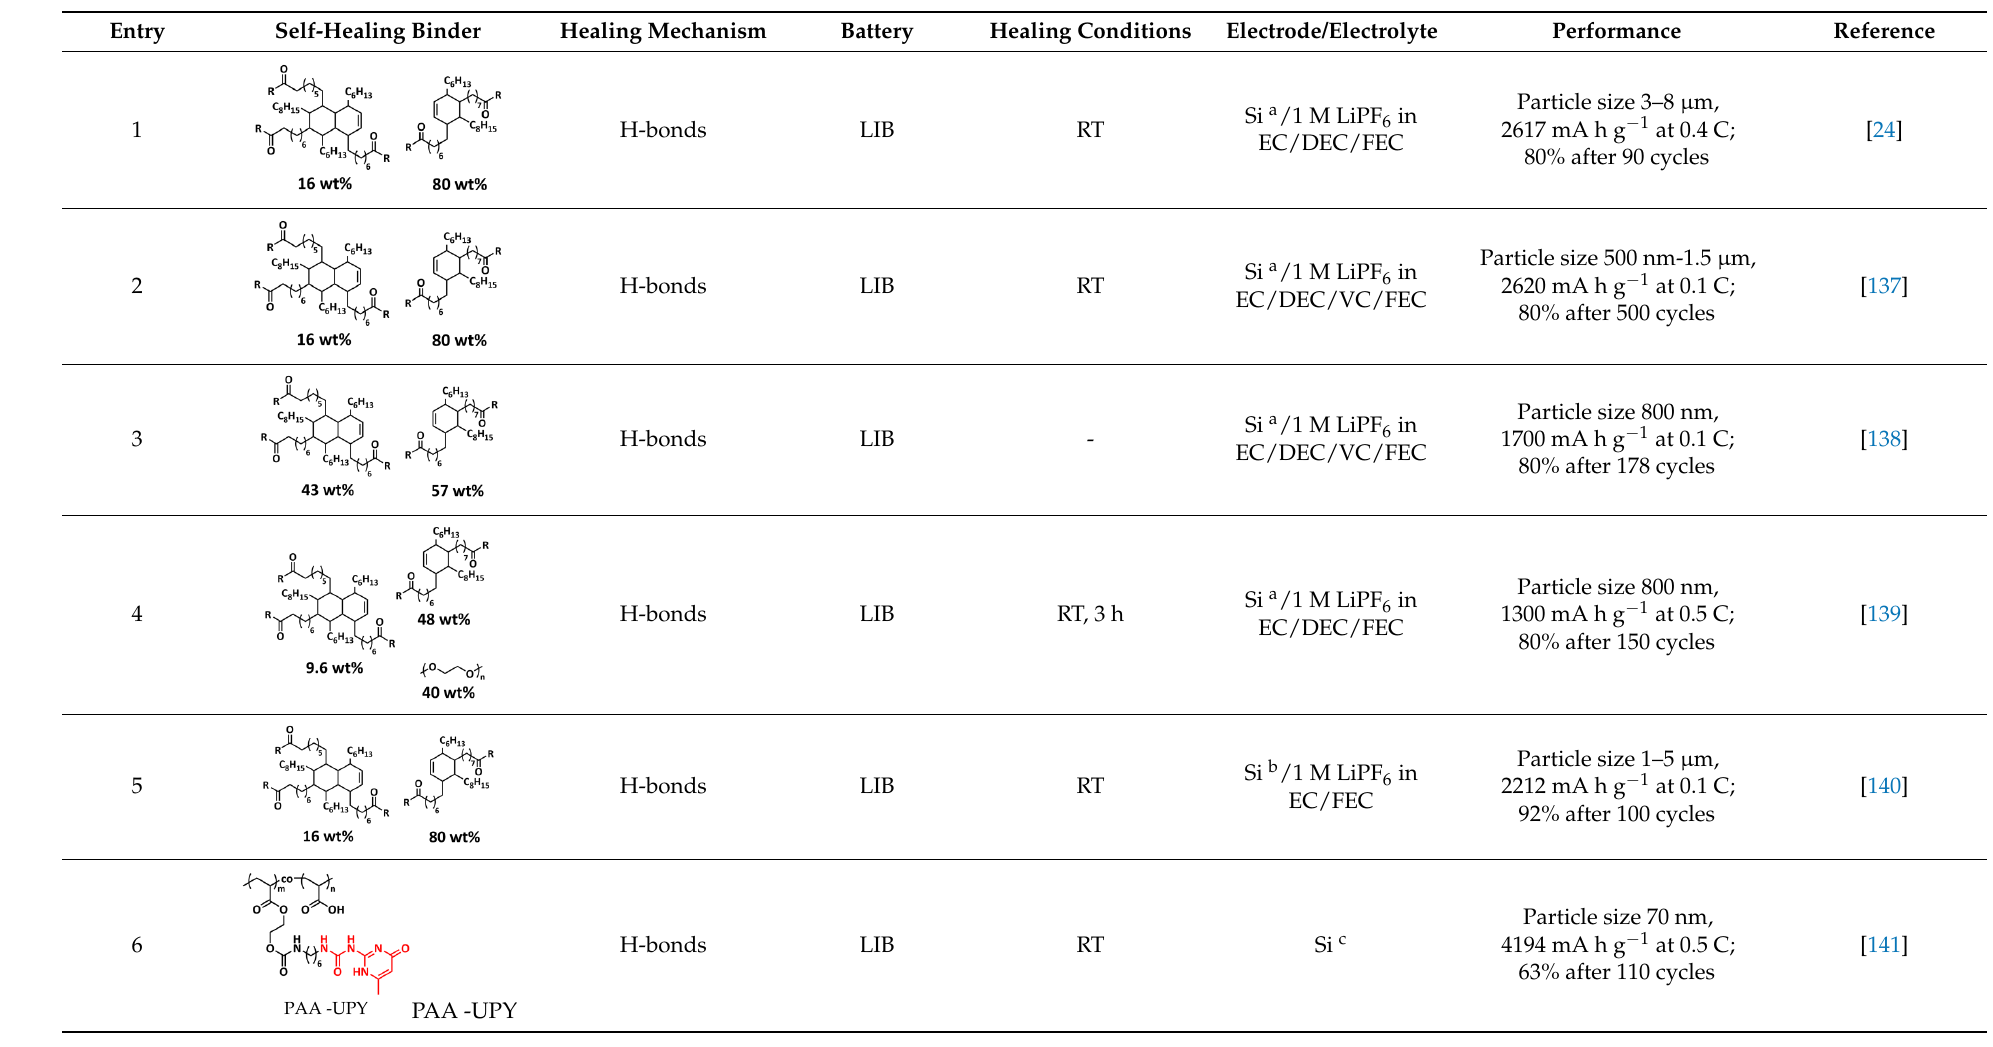
Table 2. Various self-healing polymers evaluated as binders for Si- and Li-metal anodes.